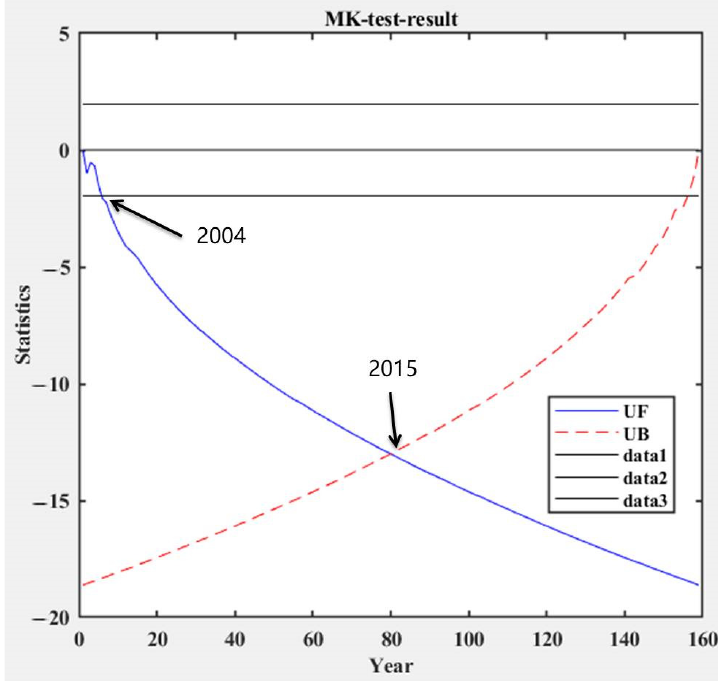
Figure 9. Mann-Kendall test result.